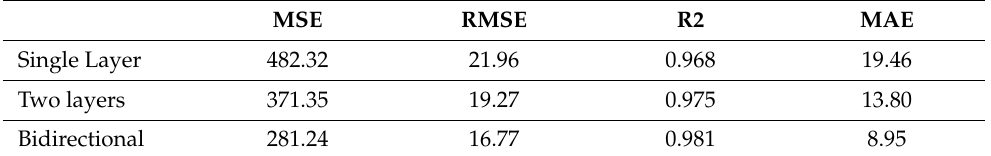
Table 2. Performance evaluation.